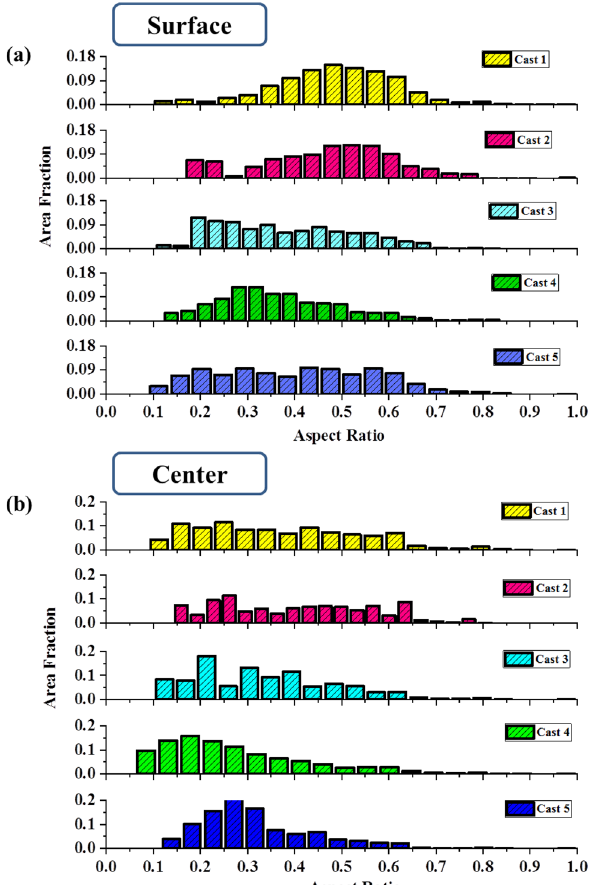
Figure 9. Grain shape aspect ratio distribution in the ( a ) surface layers and ( b ) central layers of all the hot bands produced from different